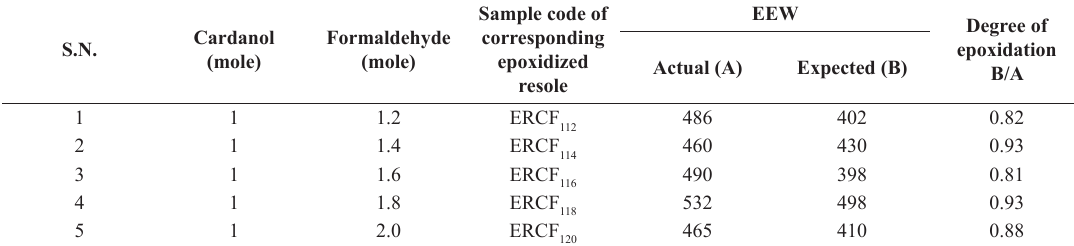
Table 1. Sample designation and epoxy equivalent weight.